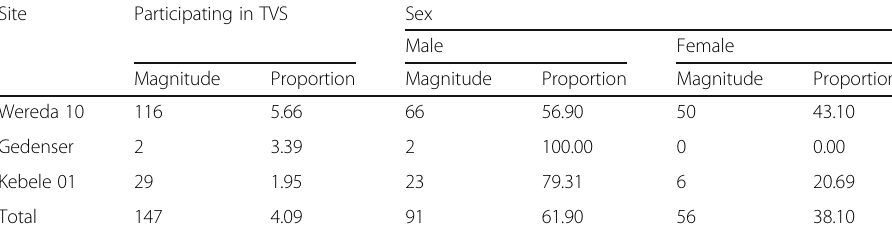
Table 3 Youth participation on technical and vocational school and corresponding gender distribution in overall project sites Site